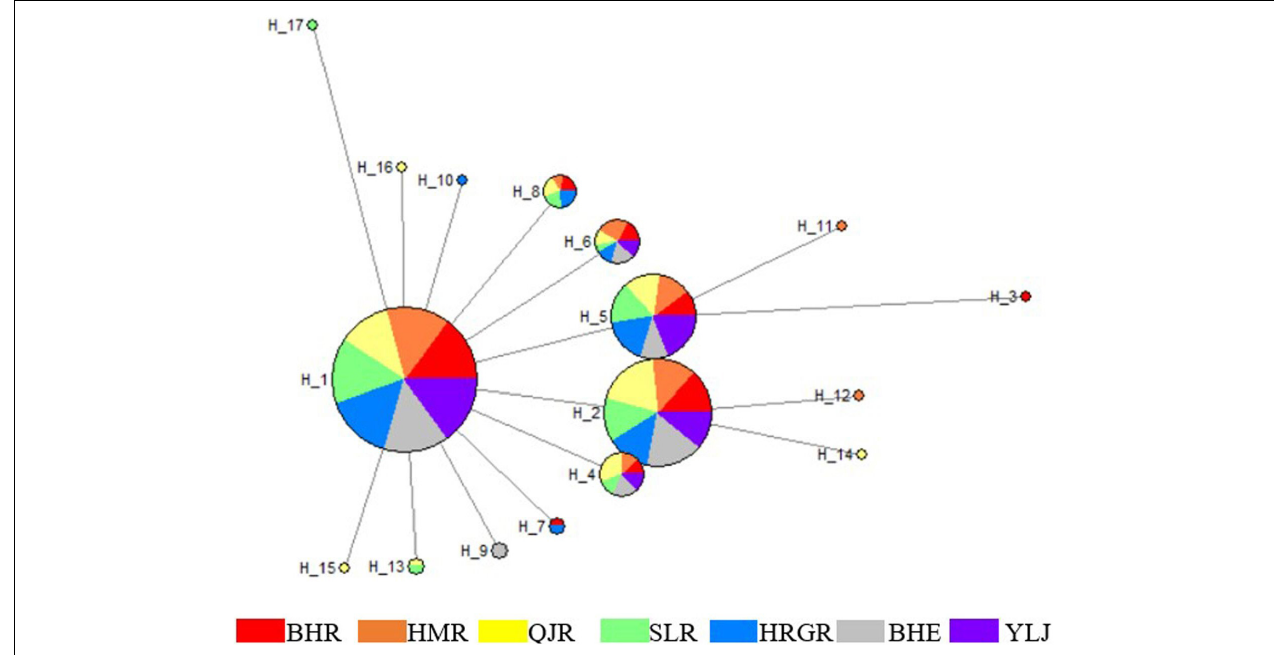
FIGURE 2 | Haplotype network of G. przewalskii based on COI gene. Each circle represents a haplotype and its size is proportional to haplotype frequency. Numbers indicate the name of haplotypes and colors represent geographic locations.